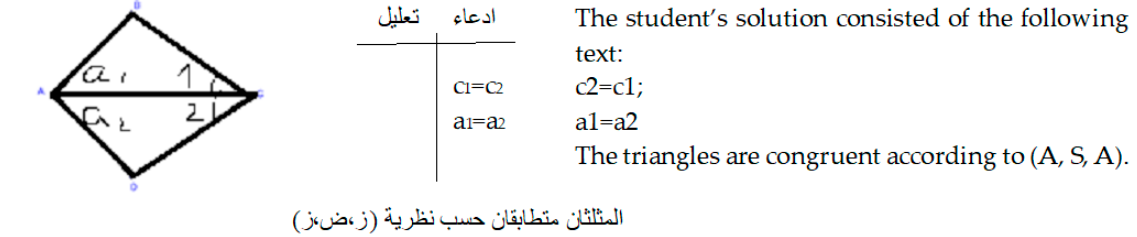
Figure 10. Writing the claim without an explanation.